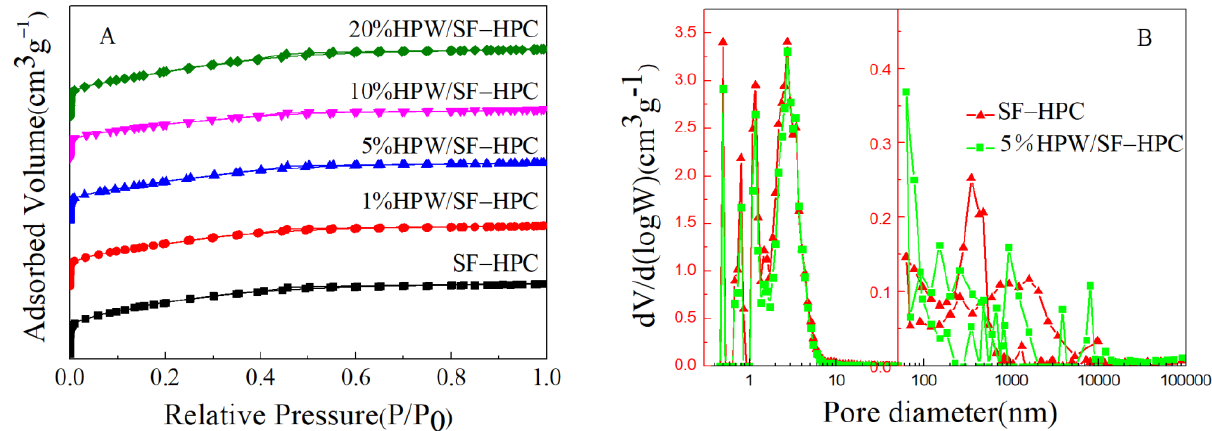
Figure 4. ( A ) Nitrogen adsorption/desorption isotherms of samples. ( B ) Pore size distribution curves of SF-HPC and 5%HPW/SF-HPC.